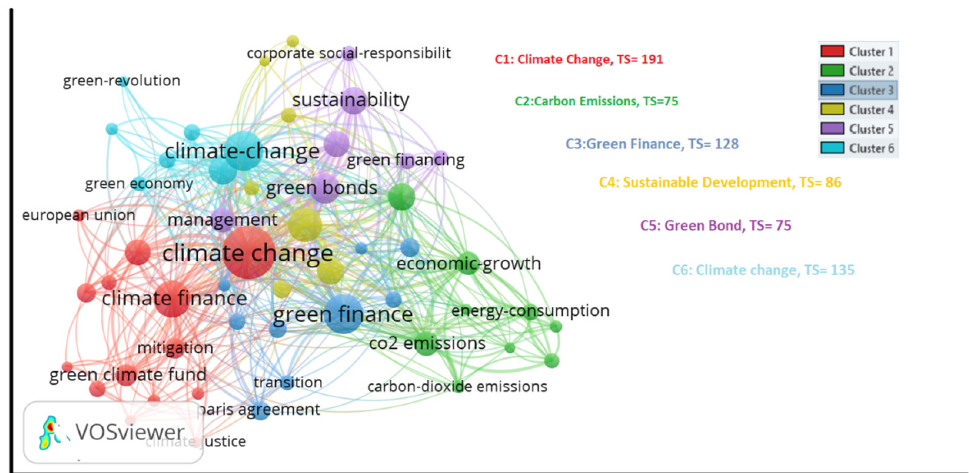
Figure 6. Co-occurrence analysis. Source: Authors’ own compilation using VOSviewer software.